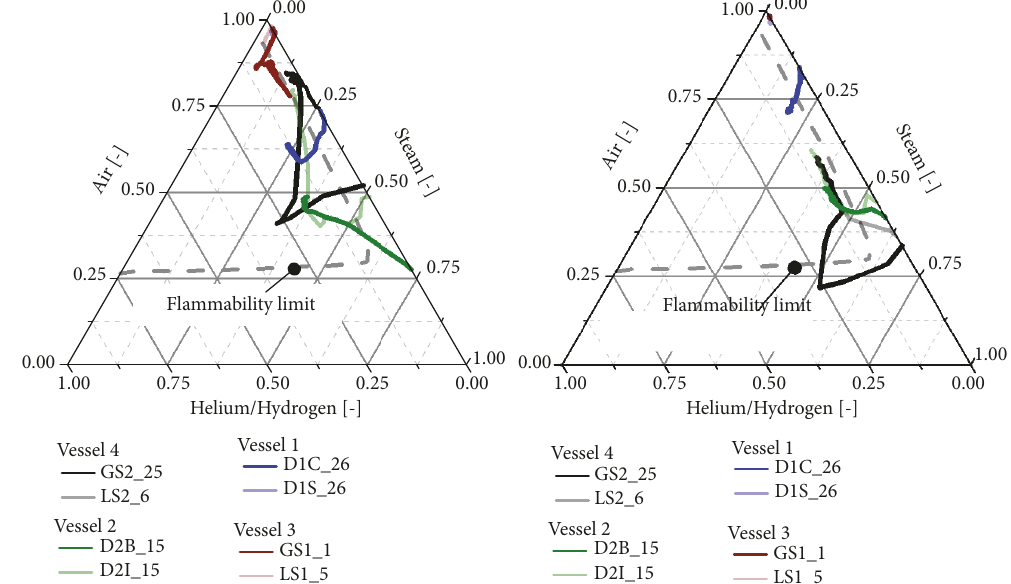
Figure 11: Shapiro diagram with flammability limit for helium (hydrogen)-air-steam mixtures at 1 bar for experiment HP6 1 (left) and HP6 2